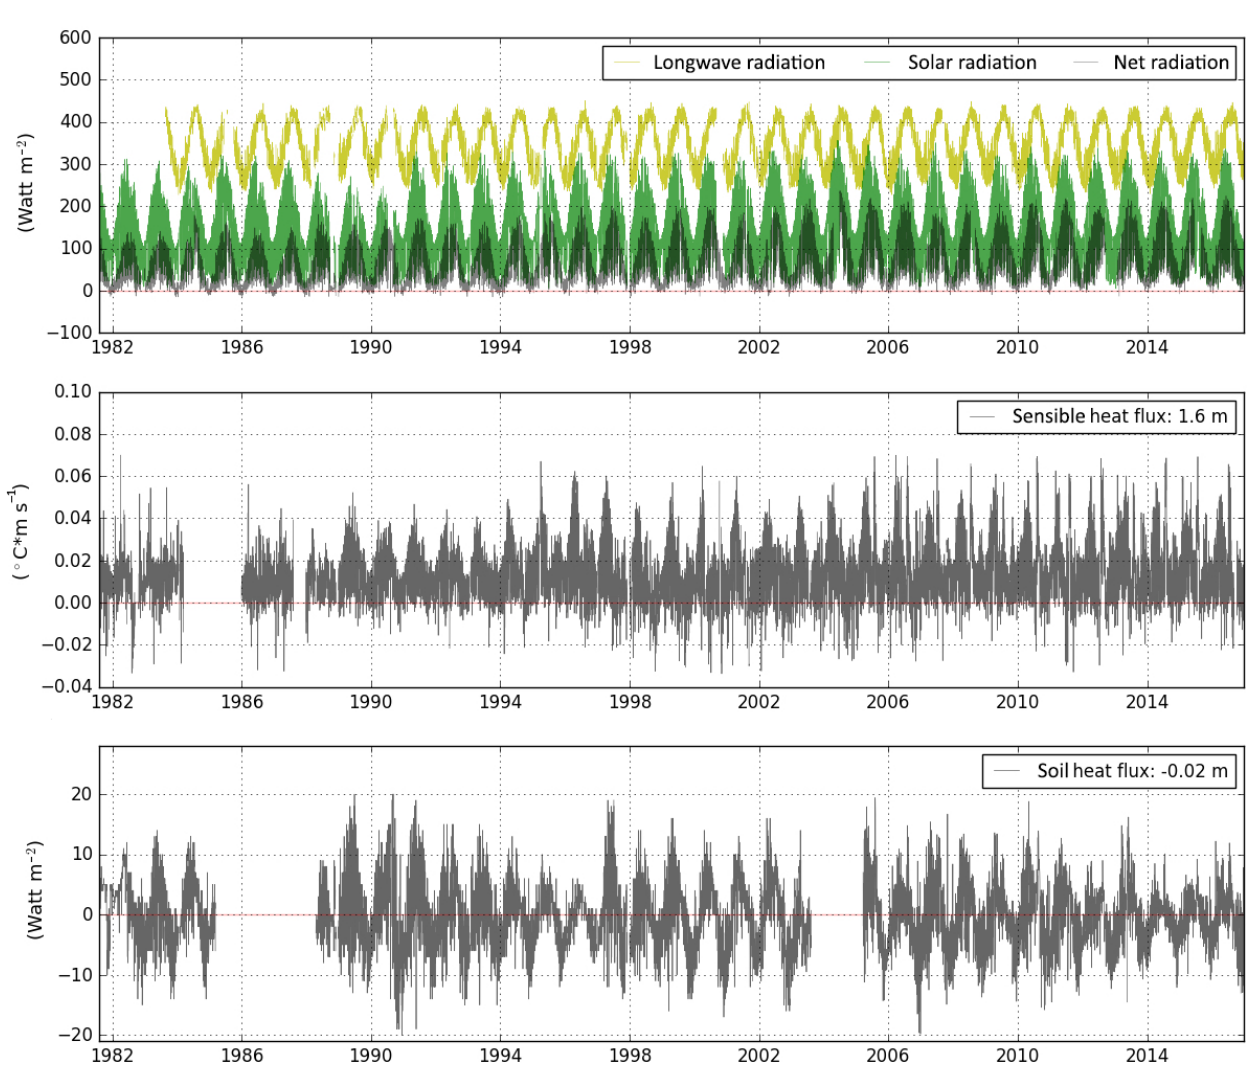
Figure 4. Daily observed values of the air temperatures for all layers, maximum, minimum and mean air temperature at a height of 1.6m, soil and dew temperatures for all layers, the precipitation, air pressure, humidity, wind speed, longwave radiation, solar radiation, net radiation, sensible heat flux and the soil heat flux at the EDP site from 1981 to